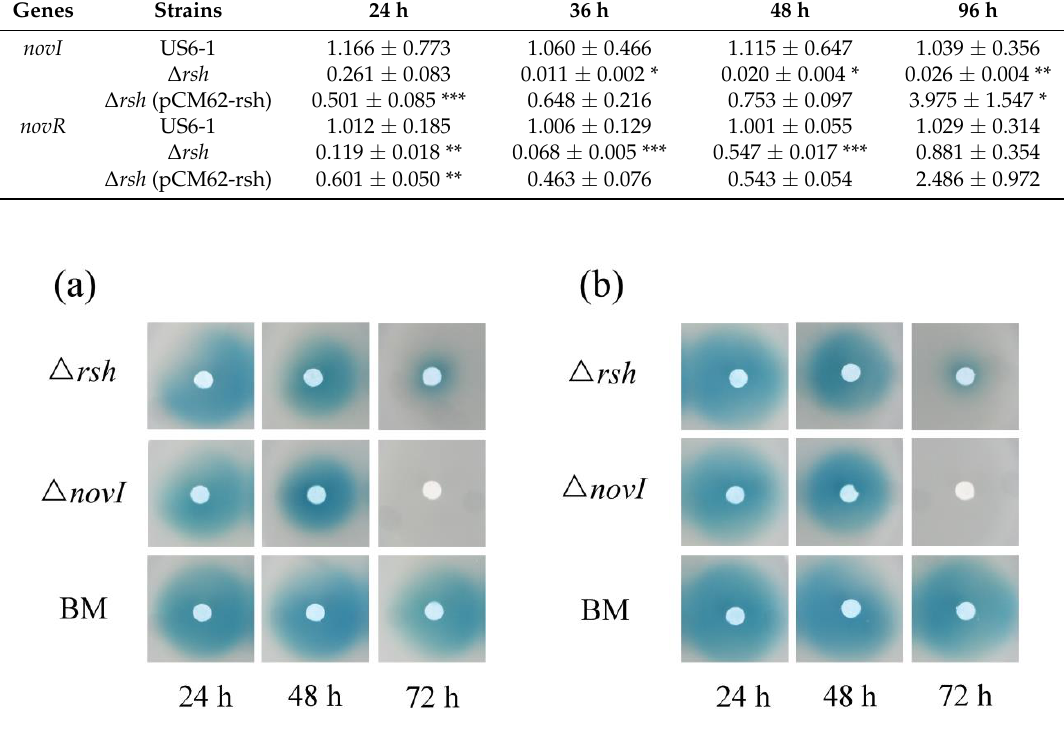
Figure 5. Identification of degradation of the medium-chain AHL by ∆ rsh . Strain ∆ rsh was incubated with 2 µM C8-AHL ( a ) and 3-OH-C8-AHL ( b ) in culture medium for 24 h (early exponential growth phase), 48 h (late exponential growth phase) and 72 h (stationary phase), after which the EA extracts were spotted onto AHL reporter plates mixed with A136. The diameters of the blue stains represent the quantity of residual AHL signals. To avoid the influence of the AHL produced by strain US6-1 in the exponential growth phase, novI deletion mutant (∆ novI ) which could not produce AHL was used as positive control. Blank medium (BM) with AHL was used as negative control.